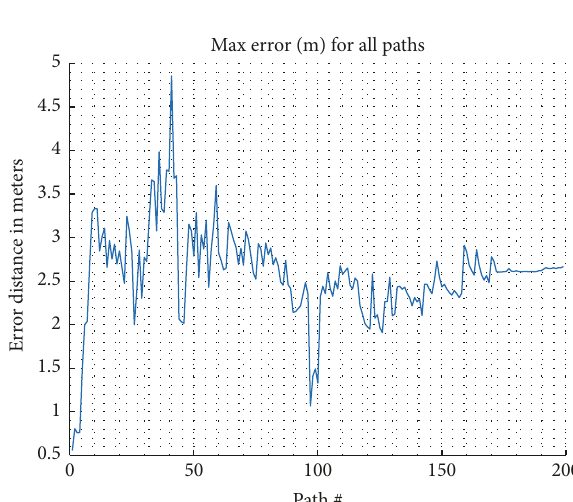
Figure 15: Combined zoom.